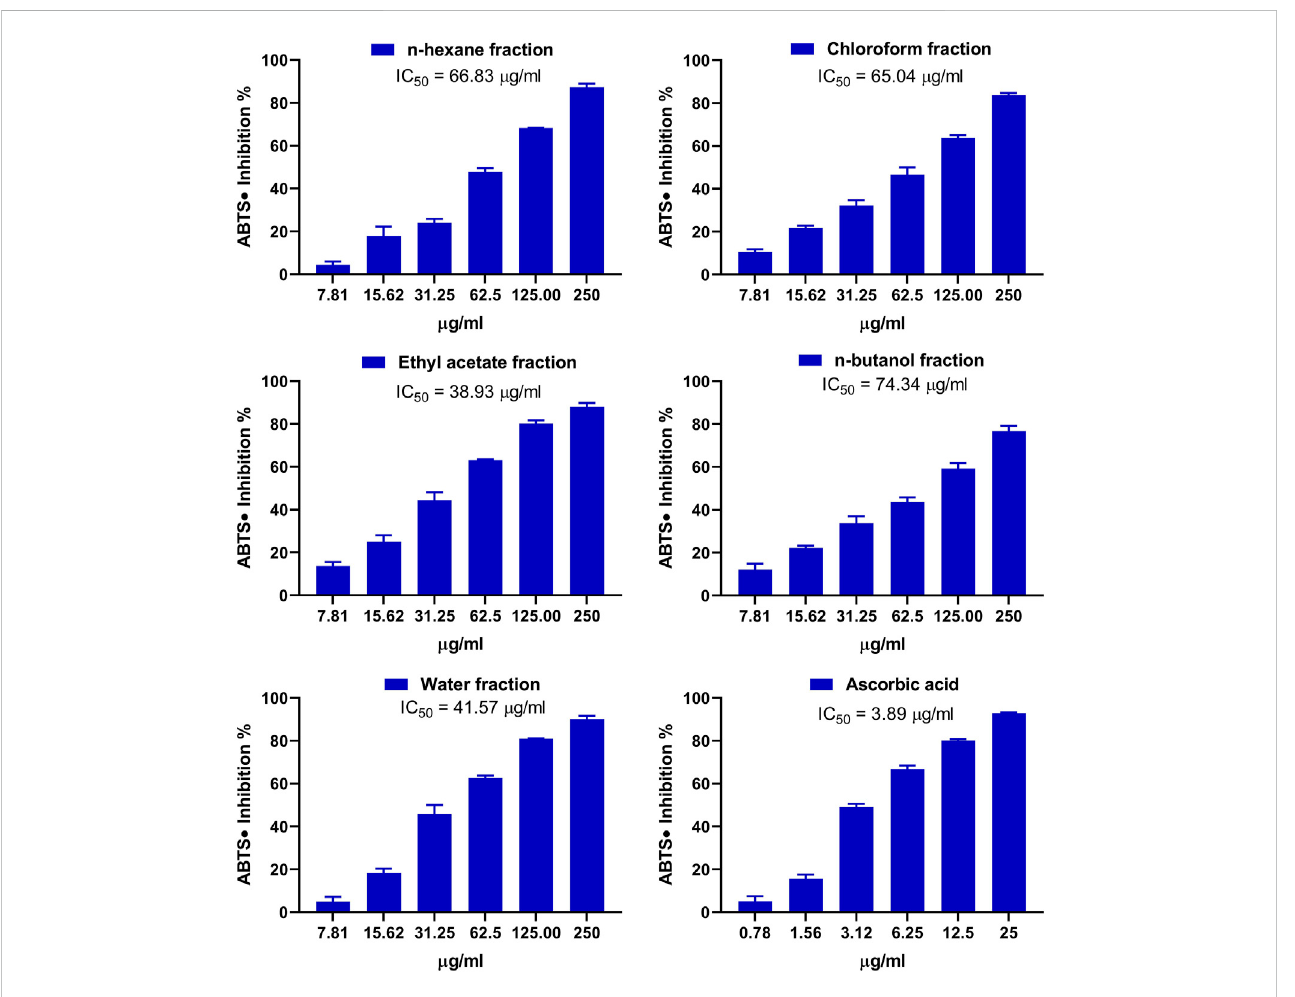
FIGURE 5 ABTS radical scavenging activity of the fractions of MEACL. Data are Mean ± SEM ( n =